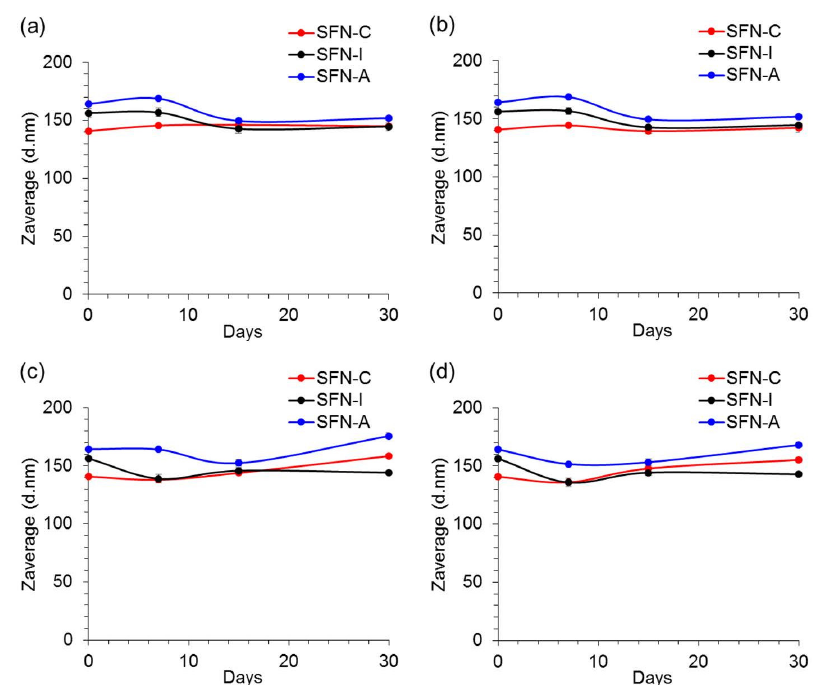
Figure 3. Effect of incubation temperature and aqueous media composition on the evolution of the hydrodynamic size (Z-average) of the non-sterilized (SFN-C, red), autoclaved (SFN-A, blue), and gamma irradiated at 5 kGy (SFN-I, black) nanoparticles for 30 days in: ( a ) Ultrapure water, 4 °C; ( b ) ultrapure water, 37 °C; ( c ) PBS 1× pH 7.4, 4 °C, and ( d ) PBS 1× pH 7.4, 37 °C. Values presented as Z-average (d.nm) ± SD (N = 9).